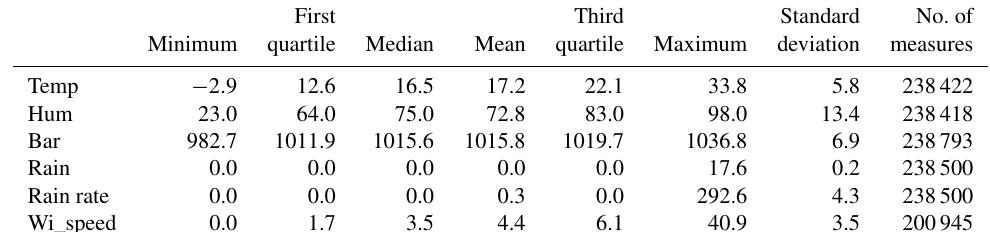
Table 7. Descriptive statistics of temperature and meteorological data measures by DeMS.